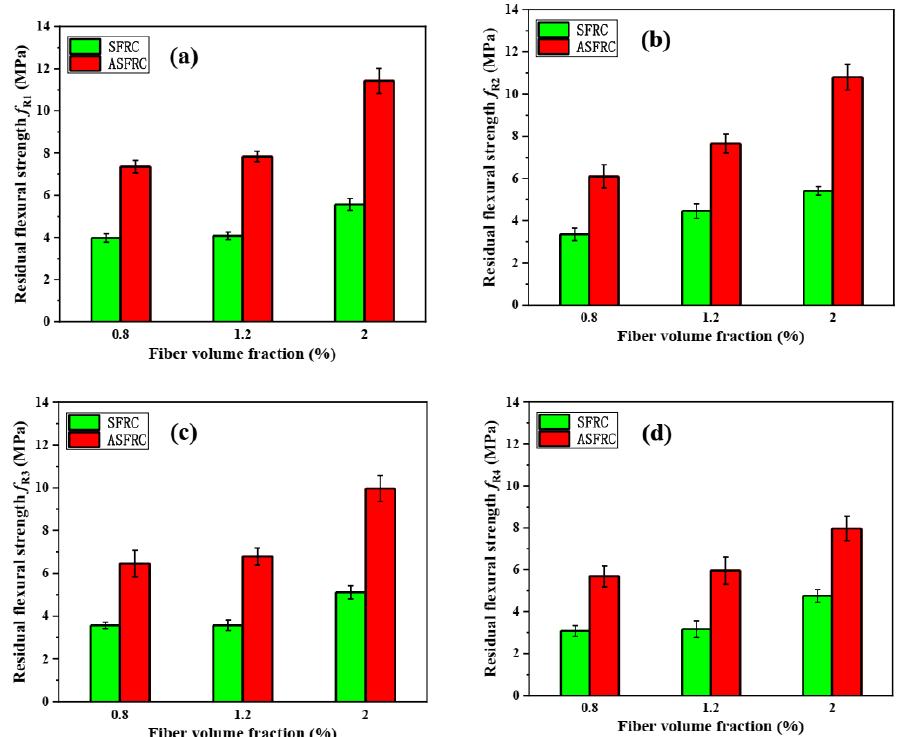
Figure 5. The residual flexural strength of SFRC and ASFRC specimens: ( a ) Residual flexural strength f R1 , ( b ) Residual flexural strength f R2 , ( c ) Residual flexural strength f R3 and ( d ) Residual flexural strength f R4